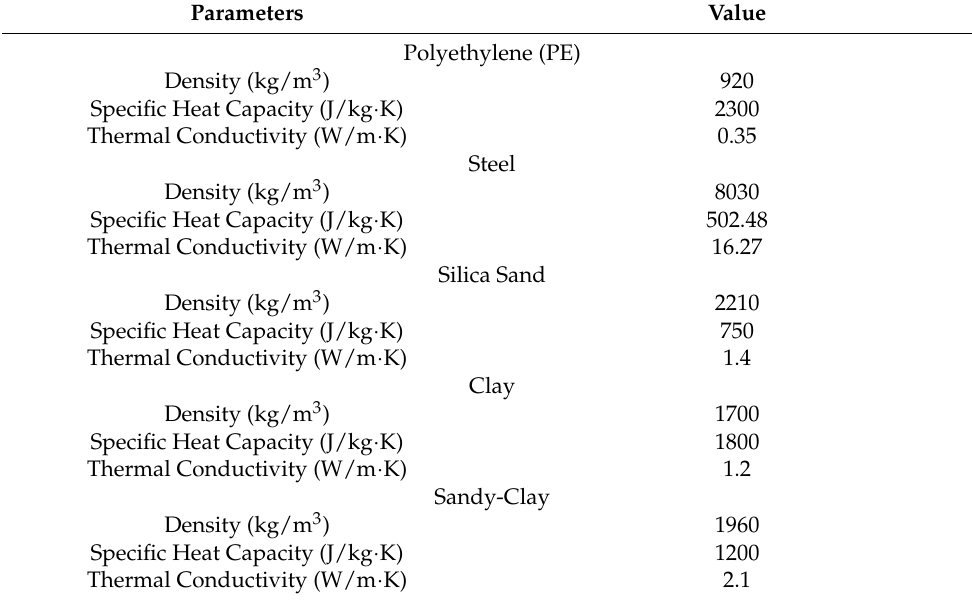
Table 2. Thermo-physical properties of U-tube, casing, backfill, and soil [18]. (Reprinted from Javadi, Hossein, Seyed Soheil Mousavi Ajarostaghi, Mohsen Pourfallah, and Mohammad Zaboli. “Performance analysis of helical ground heat exchangers with different configurations.” Applied Thermal Engineering 154 (2019): 24–36. Copyright (2019), with permission from Elsevier).